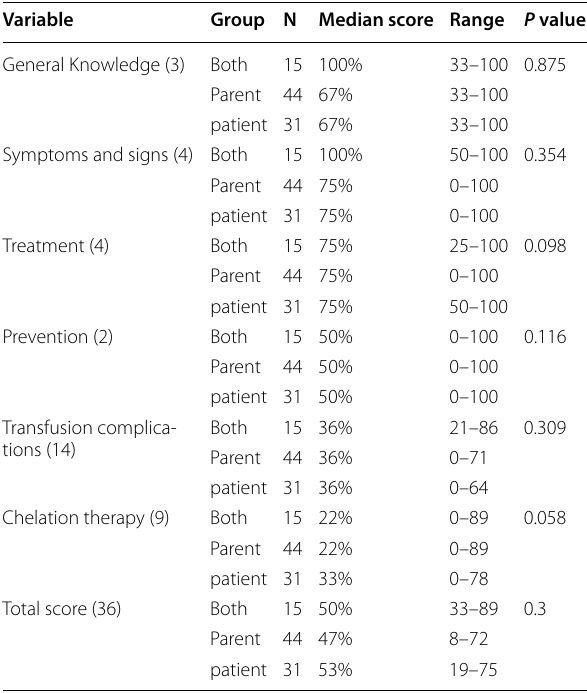
Kruskal-Wallis rank sum test used